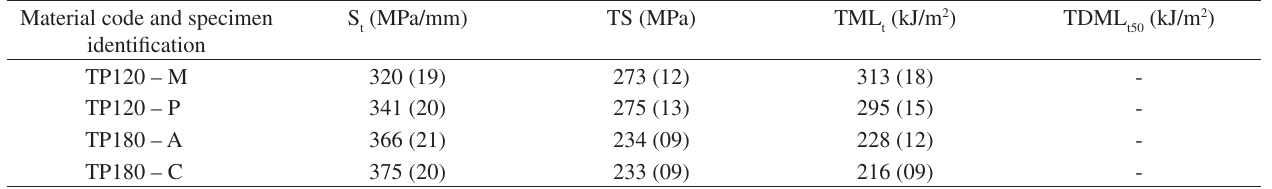
Table 2. Résumé of residual (post-fatigue) tensile tests results at 1 mm/min for carbon-epoxy composite laminates. Standard deviation is provided in paren- thesis. Material code and specimen